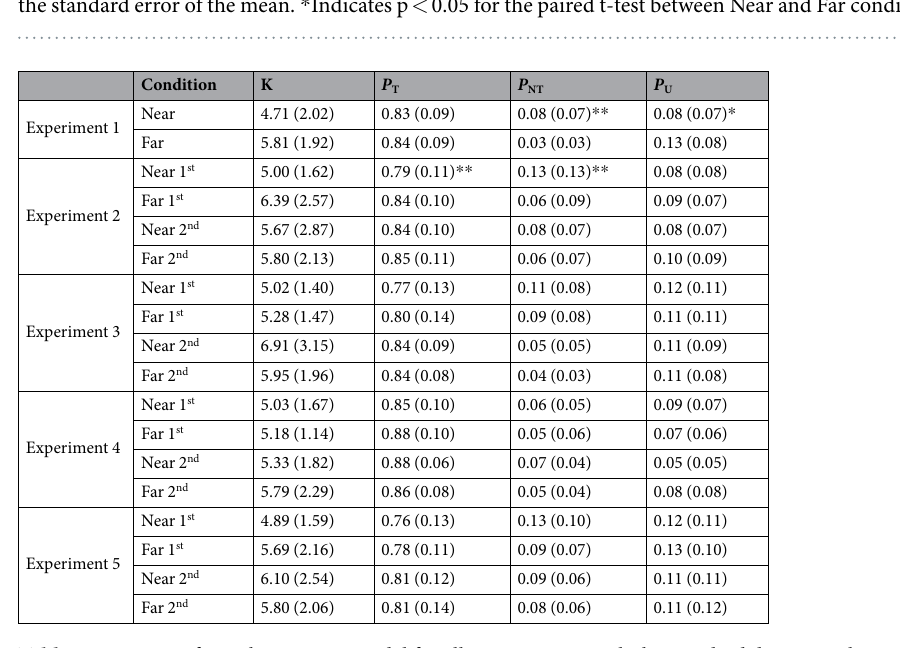
Table 1. Estimates from the mixture model for all experiments, with the standard deviation shown in parentheses. The results of paired t-tests between Near and Far conditions are shown. * Represents p < 0.05, ** represents p <